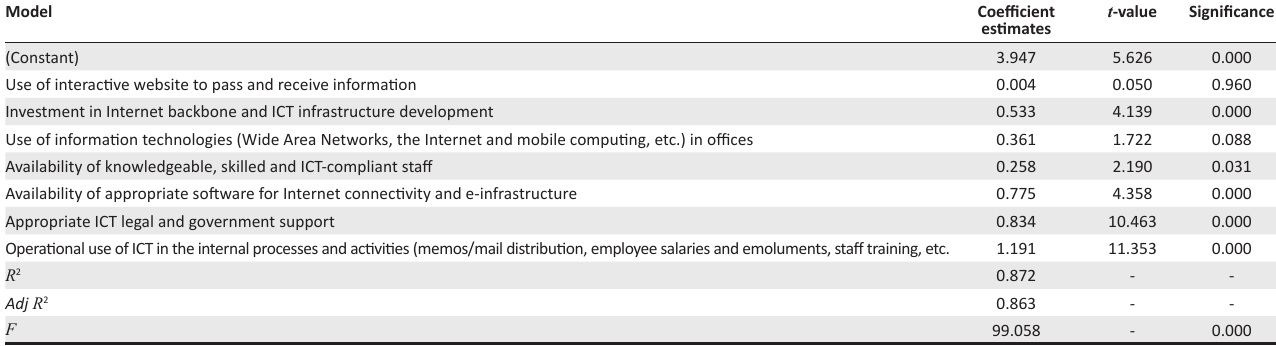
TABLE 4: Regression estimates (effect of e-governance on service culture). Model